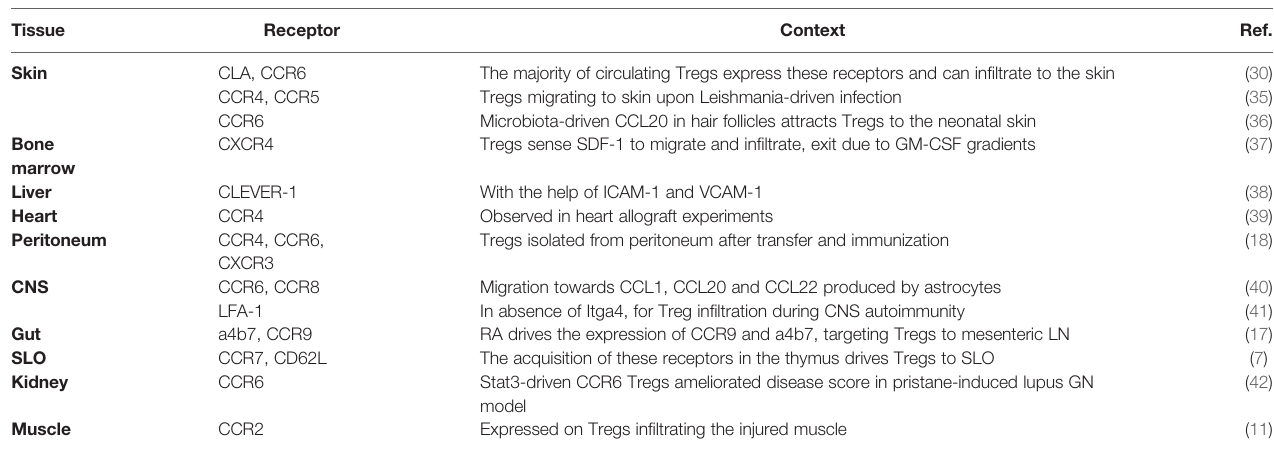
TABLE 1 | Homing receptors expressed on